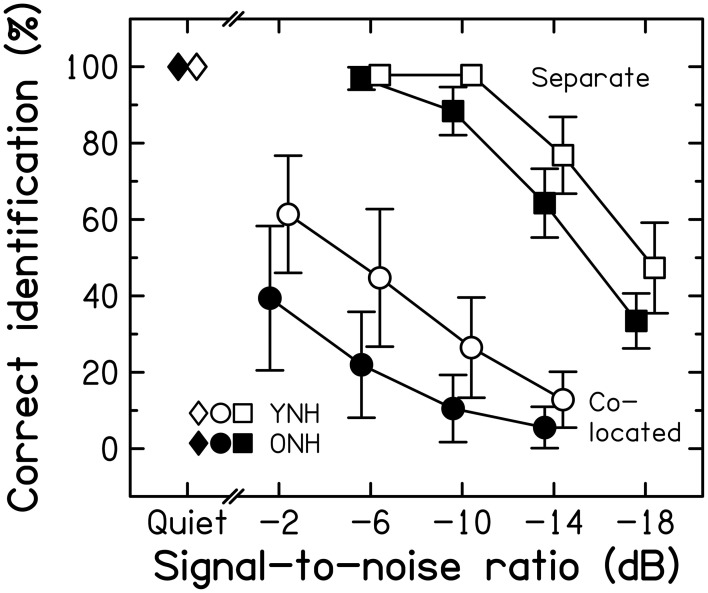
Average speech-identification scores for three listening conditions for the YNH (open symbols) and ONH (filled symbols) participants. Scores are given for the quiet condition (diamonds) and as a function of the SNR for the “co-located” (circles) and the “separate” conditions (squares). Error bars represent ±1 SD.